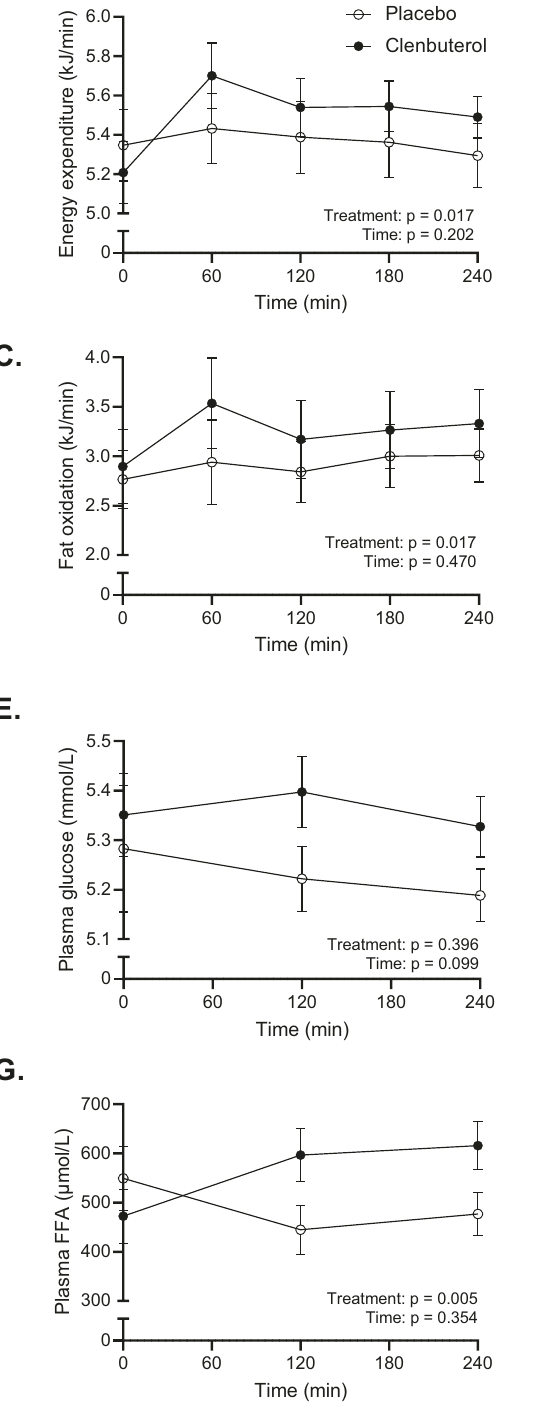
Fig. 8 | Acuteclenbuteroladministration(20 µ g)enhancesenergy expenditure and plasma free fatty acid concentrations. A Energy expenditure (kJ/min). B.Carbohydrateoxidation(CHO)(kJ/min).C.Fatoxidation(kJ/min).D.Respiratory exchange ratio. E. Plasma glucose concentrations (mmol/L). F. Plasma insulin concentrations (mU/L). G. Plasma free fatty acid (FFA) concentrations ( µ mol/L).